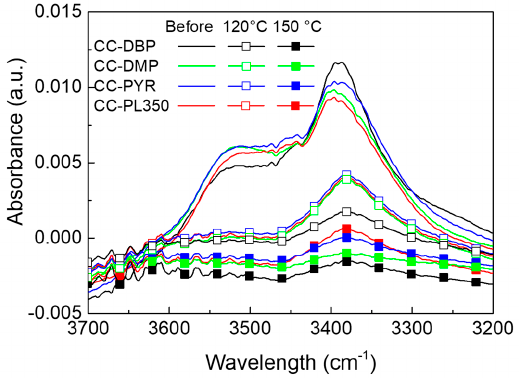
Figure 2. Changes in OH stretching vibration (3200–3700 cm − 1 ) in the HFUMO before and after thermal curing of various clearcoats at 120 and 150